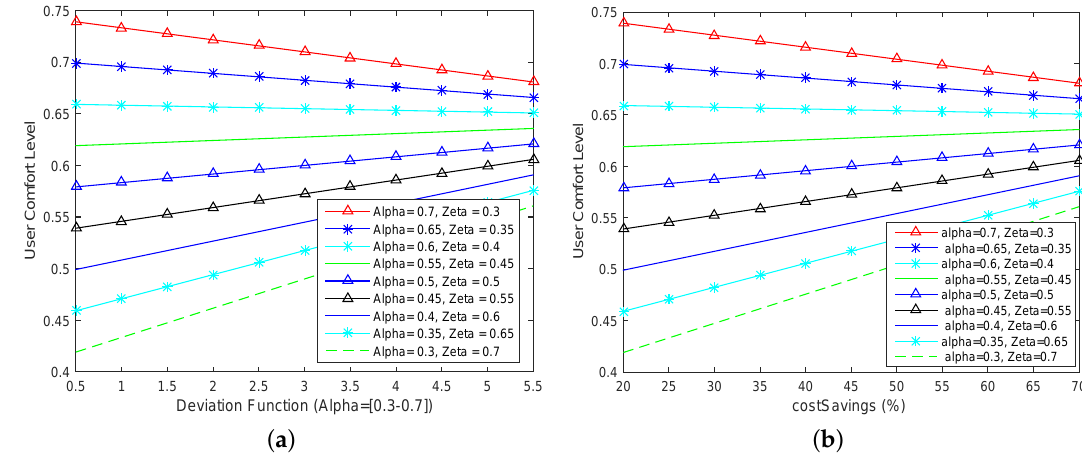
Figure 4. User comfort level keeping α = [0.3–0.7] and ζ = [0.3–0.7]. ( a ) UCL w.r.t the appliance utility function; ( b ) UCL w.r.t the cost saving function.